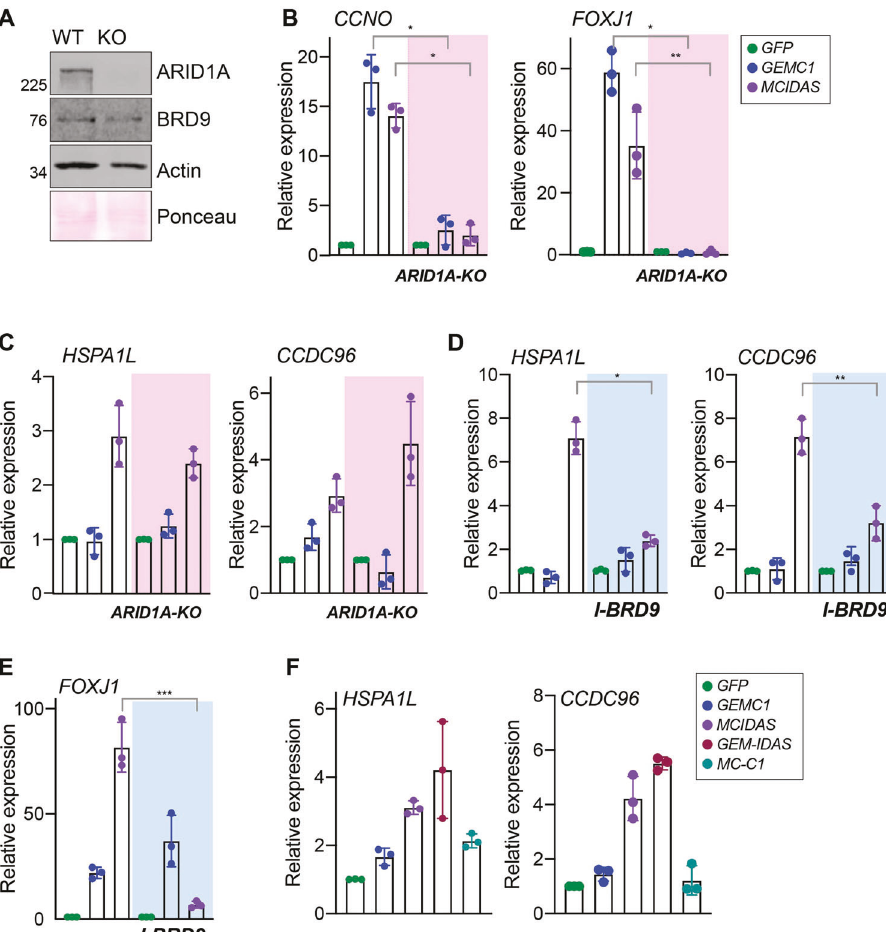
Fig. 4 Transcriptional dependence on SWI/SNF subcomplexes. A Validation of AD-293 ARID1A knock-out (KO) cells. Western blots for ARID1A and BRD9 are shown. Actin and Ponceau staining serve as loading and transfer controls. B Quantitative real-time PCR (qRT-PCR) analysis of CCNO and FOXJ1 expression in AD-293 cells following transfection with the indicated genes. WT vs ARID1A-KO p -values were 0.0287* and 0.045* for GEMC1 and 0.026* and 0.007** for MCIDAS . Transfected genes are color coded in the key to the right. C . qRT-PCR analysis of HSPAL1 and CCDC96 in parental or ARID1A-KO AD-293 cells. Statistical analysis as in B revealed no signi fi cant differences. D qRT-PCR analysis of HSPAL1 and CCDC96 in parental or ARID1A-KO AD-293 cells treated with 5 μ M of I-BRD9. WT vs I-BRD9 p -values were 0.011* ( HSPA1L ), 0.006**( CCDC96 ), and E 0.0006***( FOXJ1 ) for MCIDAS . Color coding as shown in panel B . F qRT-PCR analysis of HSPAL1 and CCDC96 expression in AD-293 cells following transfection with the indicated genes. Transfected genes are color coded in the key to the right. For B – F , results from three independent experiments are shown with the bars indicating the mean and the standard deviation shown. For statistical analysis a paired t -test was used, *** p ≤ 0.001, ** p ≤ 0.01, and * p ≤